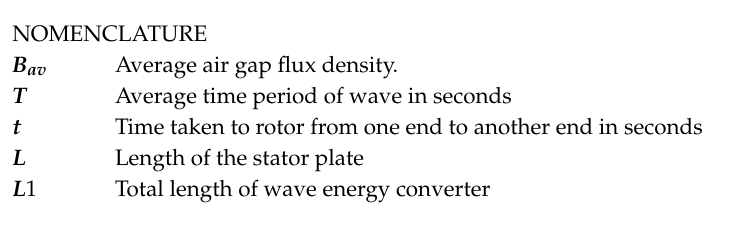
Figure 20. Back EMF voltage for linear speed of 1 m/s.